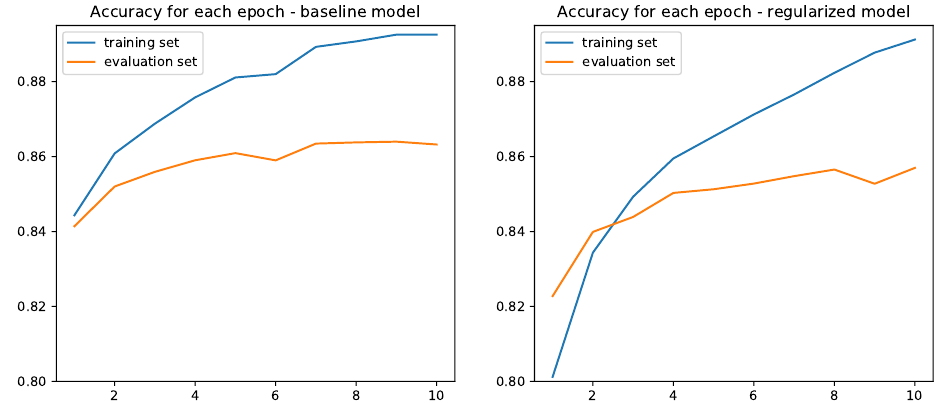
Figure A3. Learning curves with accuracy for each epoch for both models, on the training and evaluation